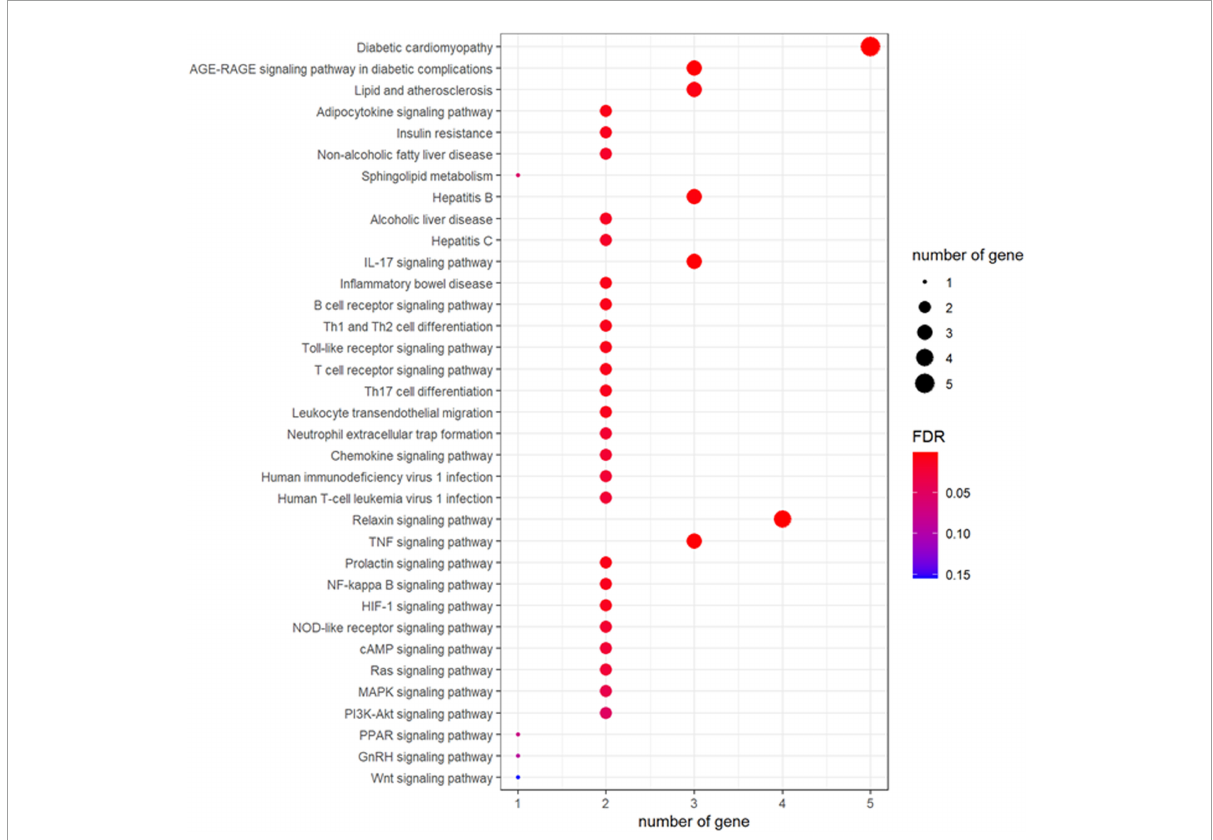
FIGURE2 Fucoidan’s targets controlled the signaling pathways involved in the pathogenesis of obesity and its associated diseases. The size of the bubble represented the number of involved genes and the color of the bubble represented the significance of the terms.